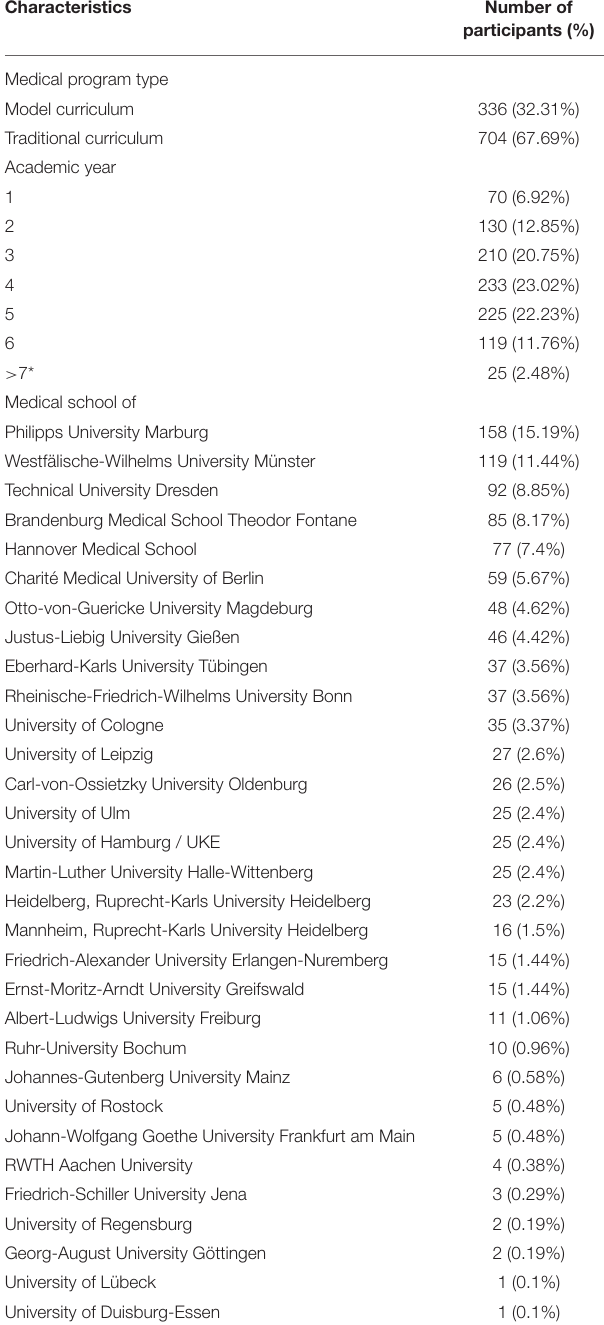
TABLE 1 | Baseline